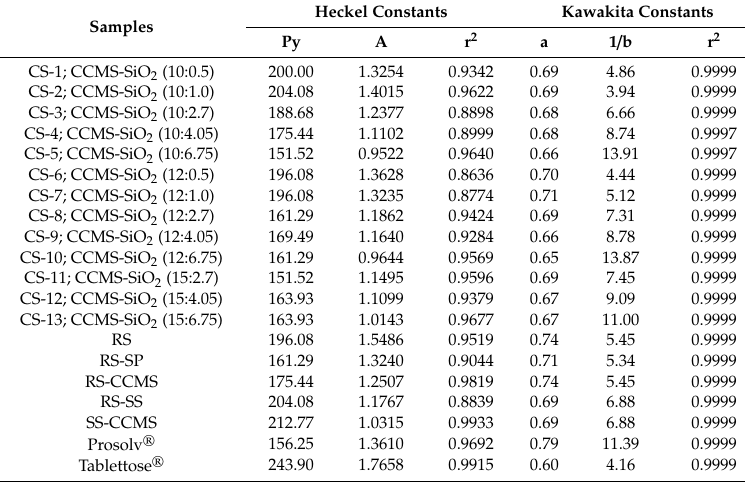
Table 3. Heckel and Kawakita calculated constants of CSs, RS, RS-SP, RS-CCMS, RS-SS, SS-CCMS, and commercial DC excipients.